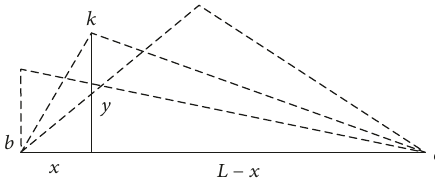
Figure 2: Location boundary of fl